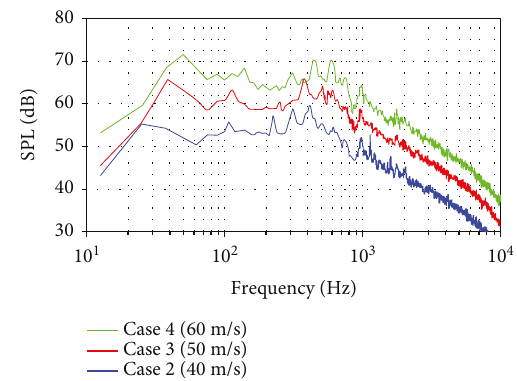
Figure 8: A-weighted SPL spectra of the cavity noise at di ff erent fl ow